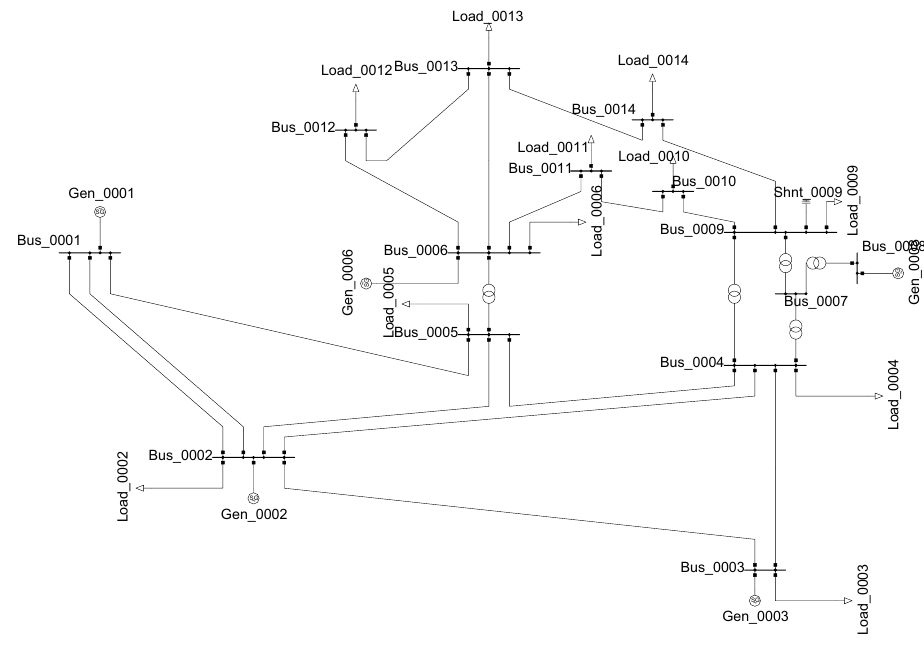
Figure 8. IEEE 14-bus test system diagram.